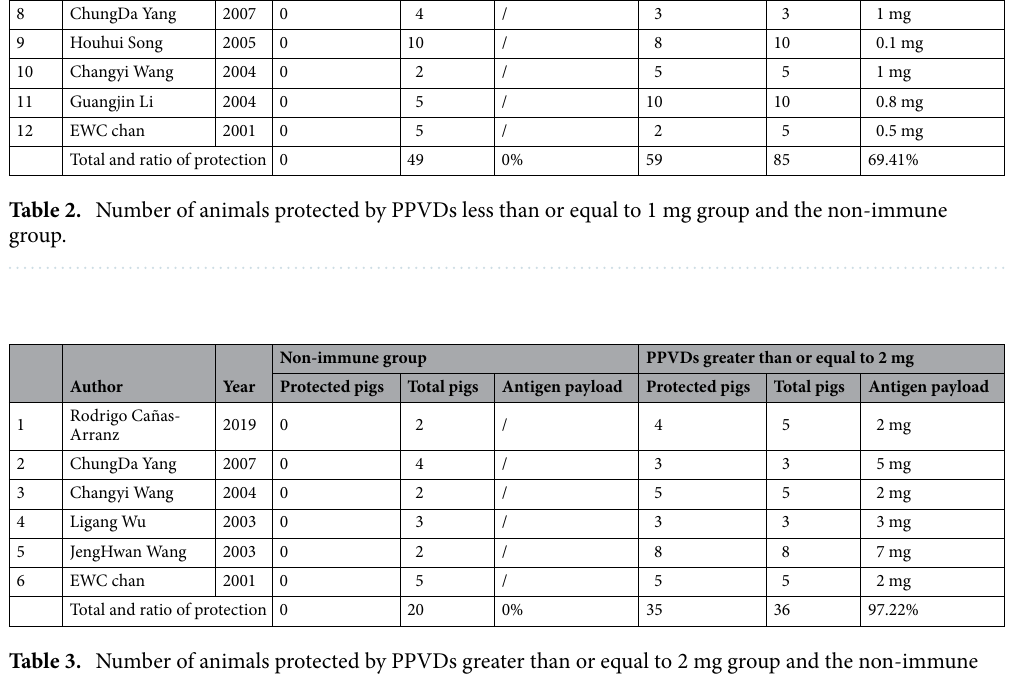
(Table 2). The OIE standard for FMDV vaccine was 75% (12/16). The data proved that the protection rate of PPVDs less than or equal to 1 mg was very low. PPVDs greater than or equal to 2 mg group provided protection against FMDV in 97.22% (> 75%) pigs (Table. 3). This rate was acceptable. The protective rate of 2 mg or more group (97.22%) was higher than that of 1 mg or less group (69.41%). Table 4 shows that 93.75% of pigs were protected against FMDV by PPVDs group of 2 mg or more. The high dose protection rate was acceptable (> 75%). However, the low dose protective ratio was terrible. The protective rate (93.75%) of the group greater than or equal to 2 mg was higher than that of the group less than or equal to 1 mg (63.16% < 75%). PPVDs group of less than or equal to 1 mg provides protection against FMDV in 56% of pigs, and the inac- tivated vaccine group provided protection against FMDV in 93.33% of pigs (Table 5). However, the group with PPVDs less than or equal to 1 mg (56%) was a terrible protection. The protective rate (56%) of the group less than or equal to 1 mg was lower than that of the inactivated vaccine group (93.33%). At present, there are only four experiments about the relationship between the PPVDs less than or equal to 1 mg group and inactivated vaccines.